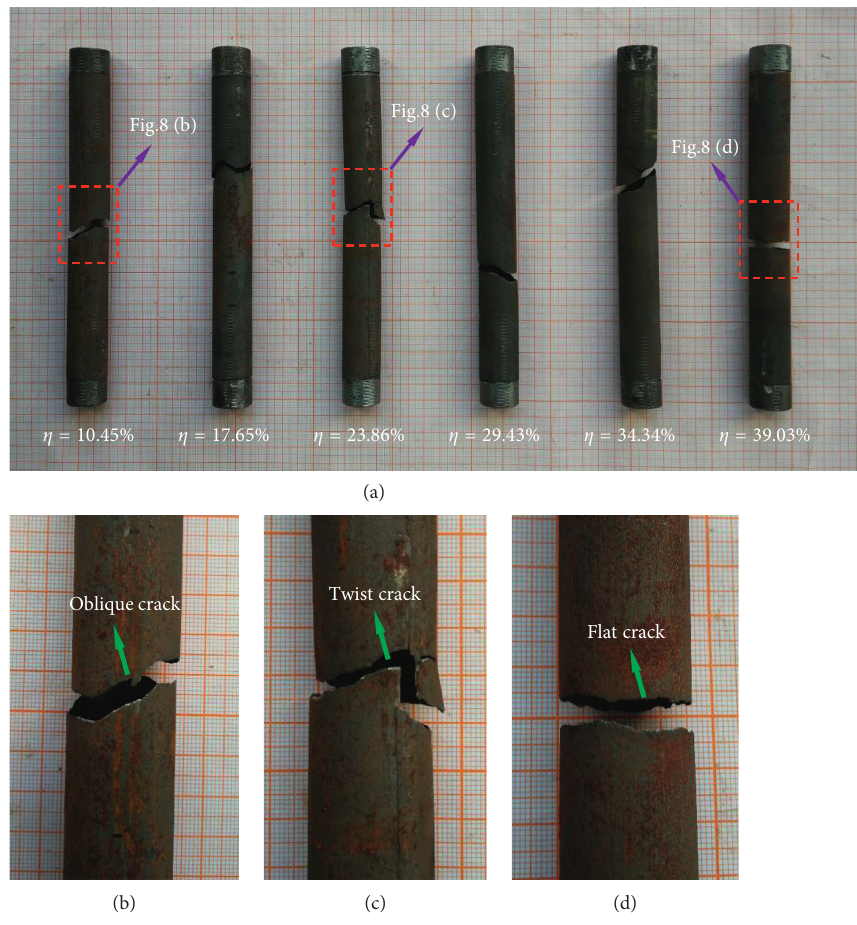
Figure 8: Fracture patterns of corroded pipe with lower corrosion